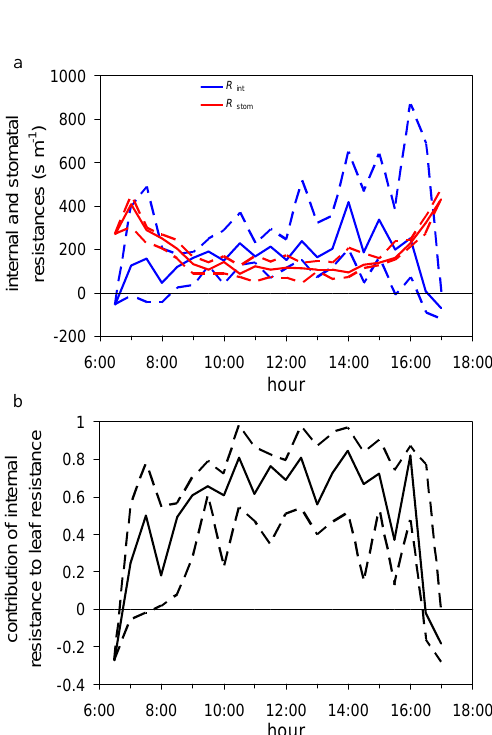
Figure 11: Half hourly medians (solid lines) and interquartile range (dotted lines) of (a) NO 2 internal (blue lines) and stomatal resistances (red lines) and (b) the relative contribution of internal resistance to the total leaf resistance (i.e.